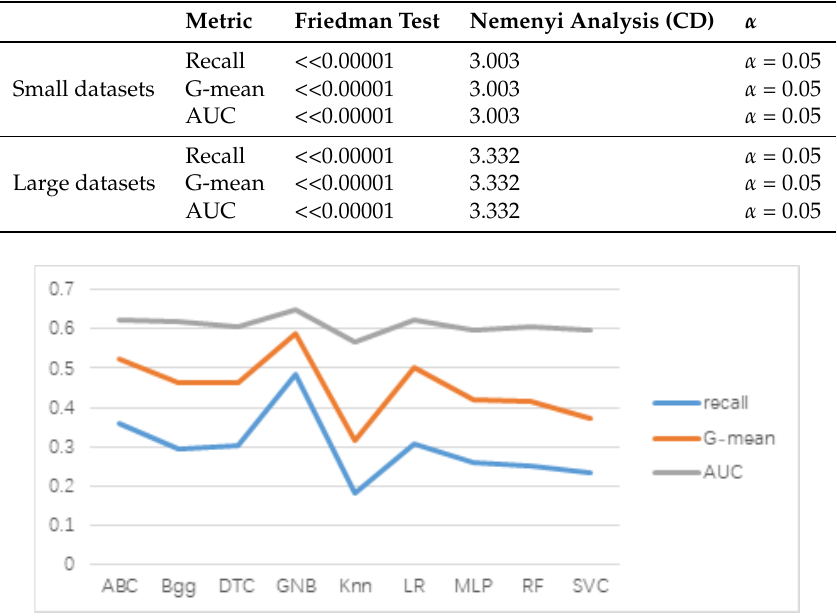
Table 6. p -Value and CD value of differences among classifier result on different datasets.